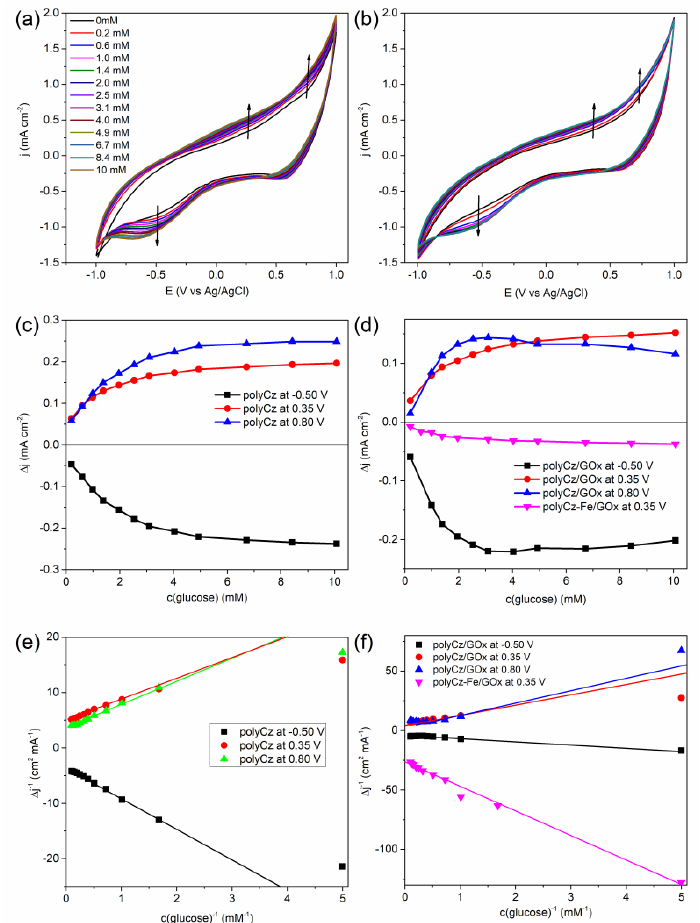
Figure 5. Current density responses for the non-enzymatic (polyCz) and enzymatic (polyCz / GOx and polyCz-Fe / GOx) electrodes under varying glucose concentration: ( a ) cyclic voltammetries (CVs) for the polyCz and ( b ) polyCz / GOx electrodes; ( c ) current densities response on the concentration of glucose in solution at pH 7.4 at − 0.5, 0.35, 0.80 V vs. Ag / AgCl for polyCz and ( d ) polyCz(-Fe) / GOx ( d ); ( e )